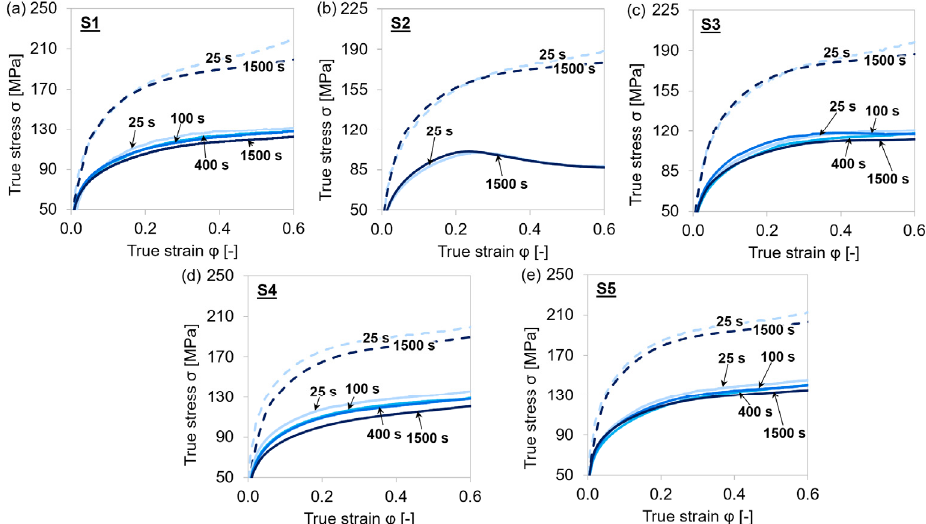
Figure 6. Stress–strain curves during single-hit compression tests with 25–1500 s holding times before deformation and 0.01 s − 1 (continuous line) as well as 1 s − 1 (dashed line) strain rates at 1153 K. ( a – e ) MA steel grades S1–S5.